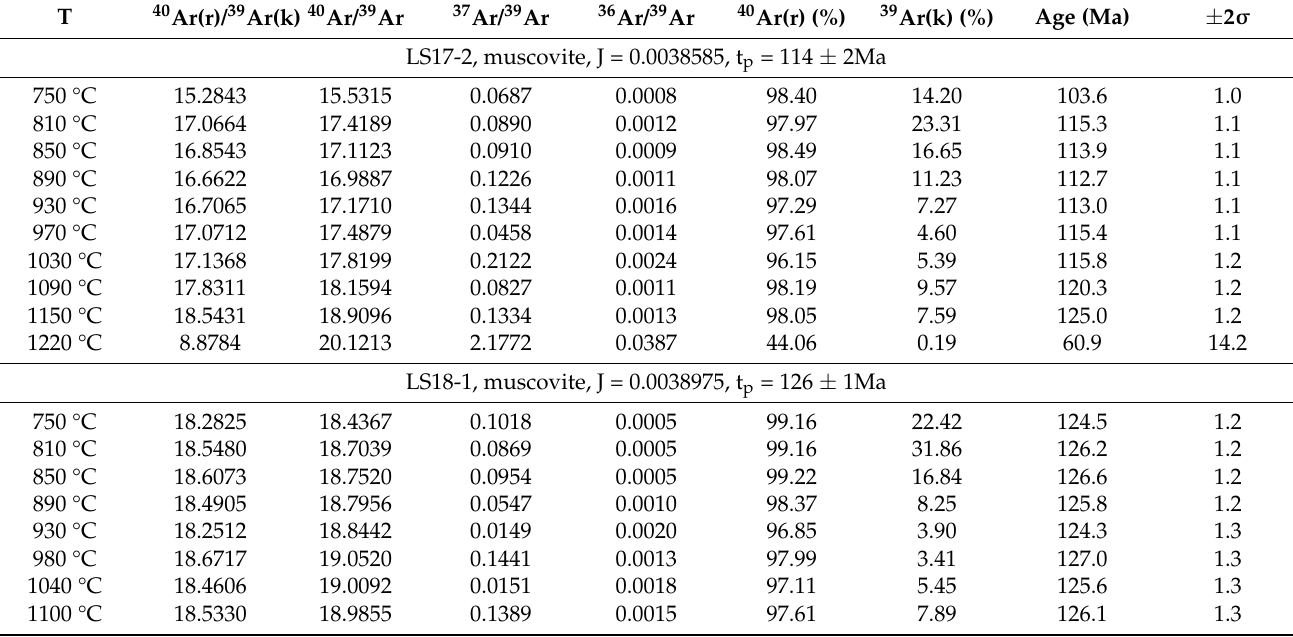
Table 1. Ar–Ar stepwise heating data for muscovite and biotite